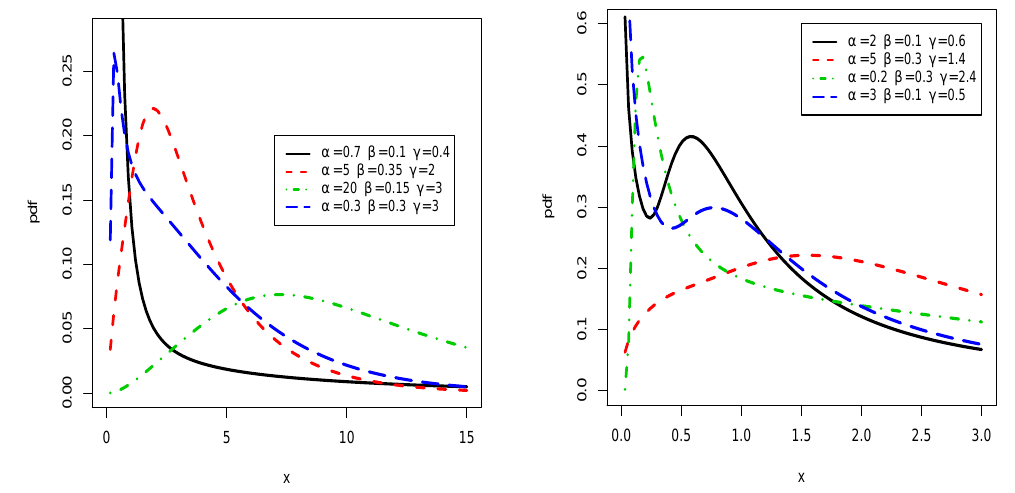
Figure 1. Plots for the pdf of the EMIEEdistribution, for several values of the